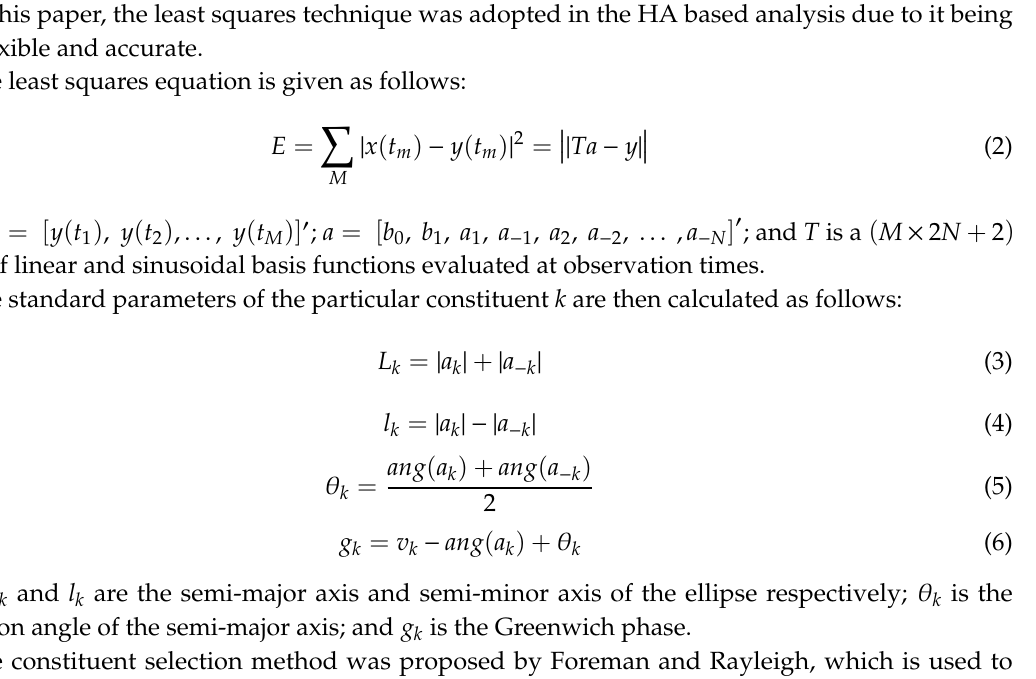
Figure 3. Diagram of a novel tidal current prediction considering the effect of the multi-layer current velocity method.